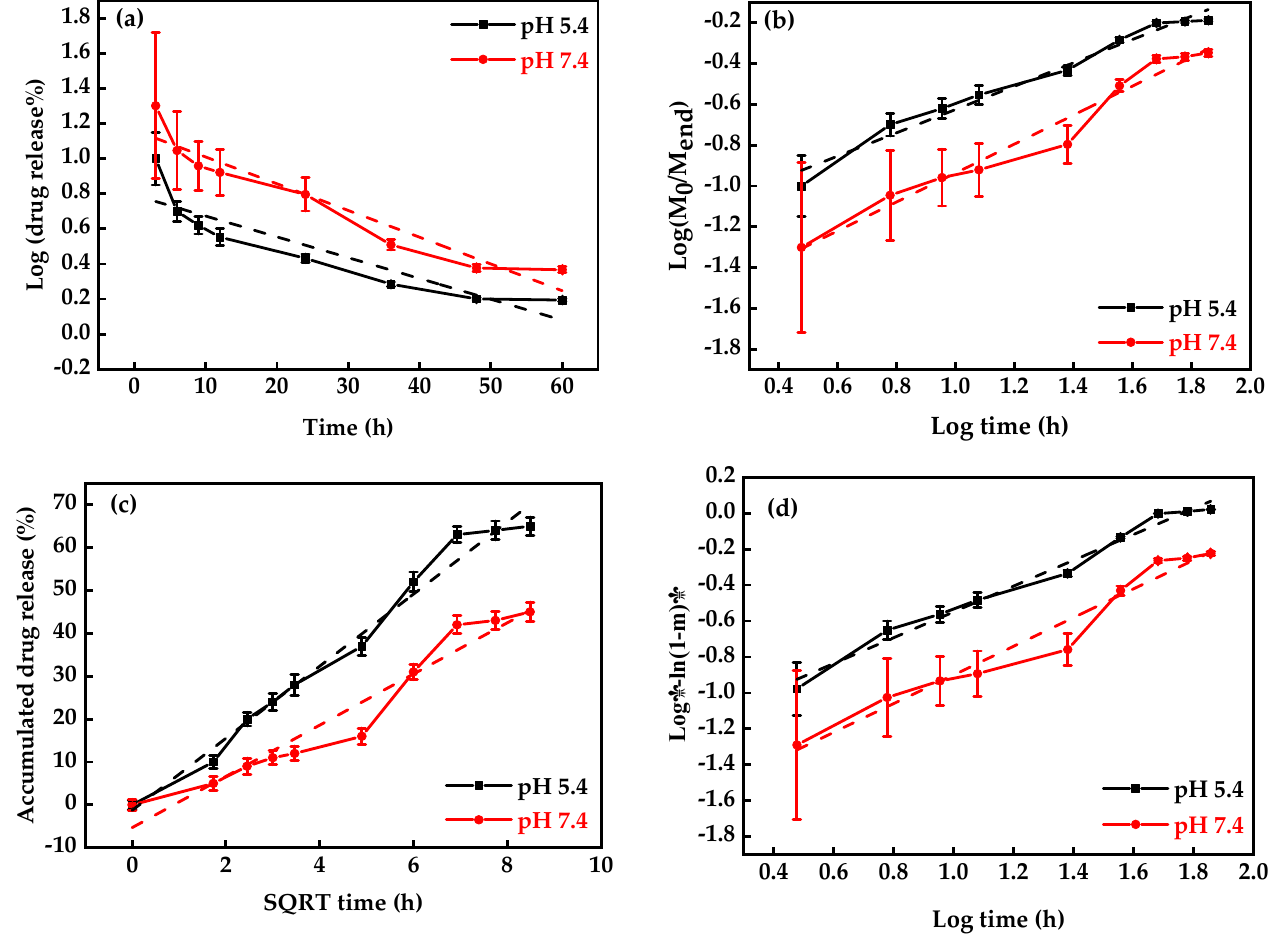
Figure 6. Drug-release kinetics plots: ( a ) Korsmeyer–Peppas, ( b ) First-order, ( c ) Weibull, and ( d ) Higuchi models under different pH values (pH = 5.4 and 7.4) at 37 °C (n = 3).